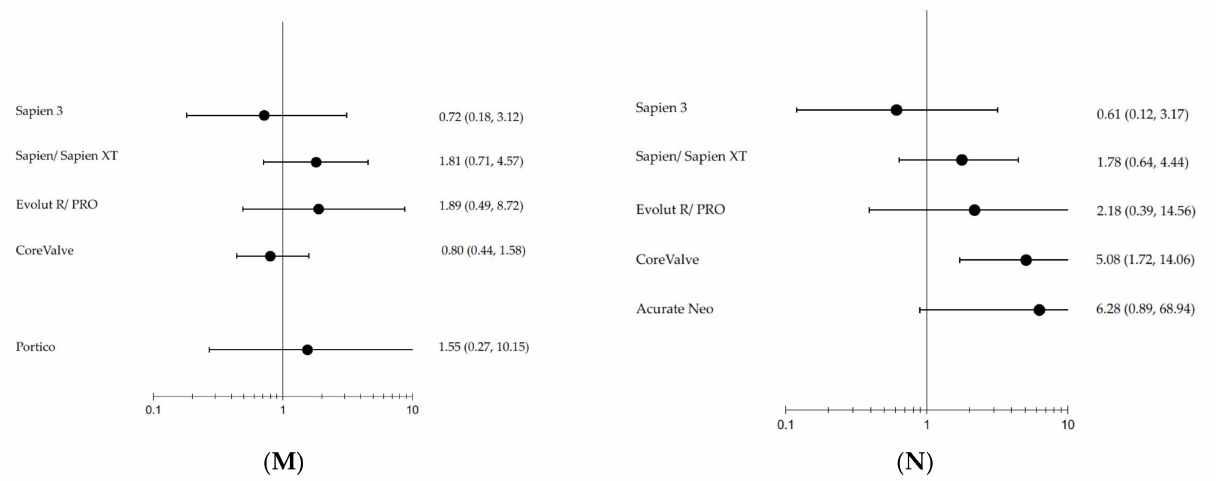
Figure 4. Forest plots of ( A ) all-cause mortality, ( B ) cardiovascular mortality, ( C ) stroke, ( D ) bleeding, ( E ) vascular complications, ( F ) acute kidney injury, ( G ) pacemaker implantation, ( H ) rehospitalization, ( I ) atrial fibrillation, ( J ) aortic regurgitation, ( K ) endocarditis, ( L ) myocardial infarction, ( M ) heart failure NYHA III-IV, and ( N ) reintervention comparing various TAVI valves to SAVR.